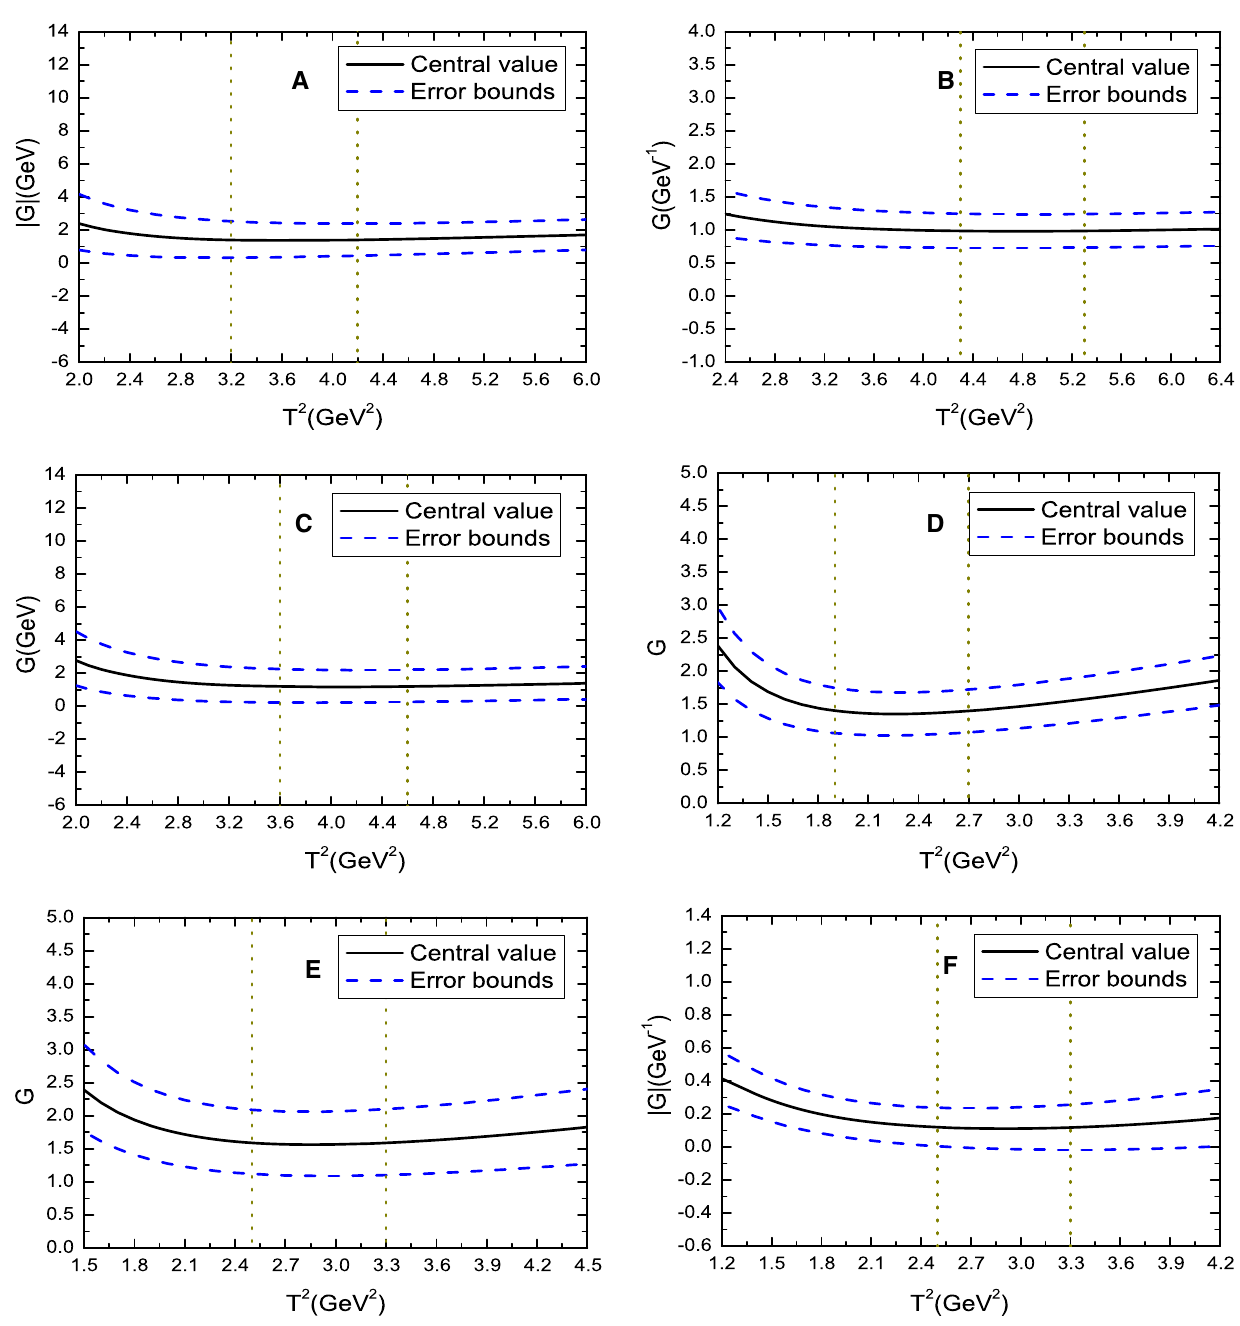
Fig. 1 The hadronic coupling constants with variations of the Borel parameters T 2 , where the A , B , C , D , E and F denote the G Y J /ψ f